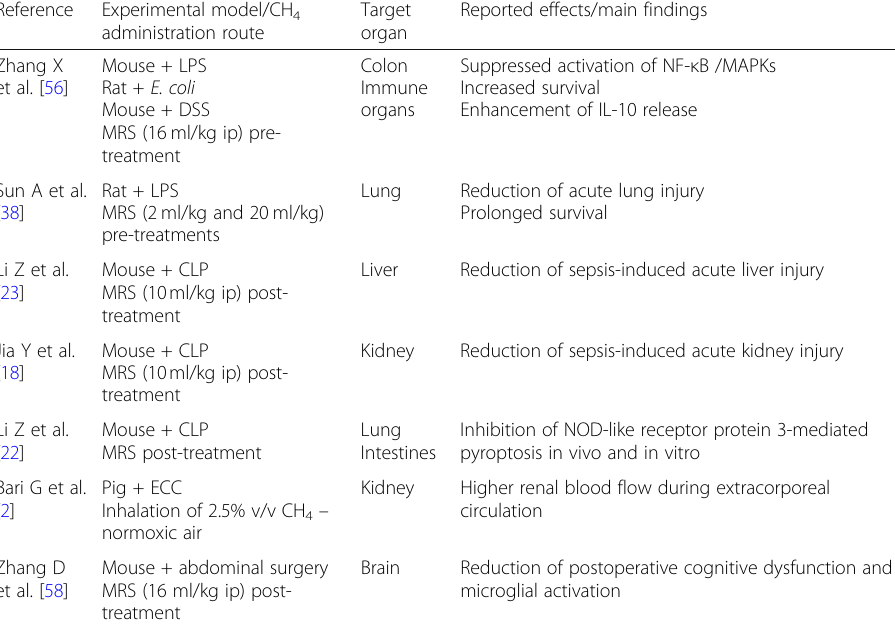
Table 1 Summary of in vivo studies using CH 4 that also monitored sepsis/LPS/surgery-induced organ dysfunction and other parameters of tissue damage